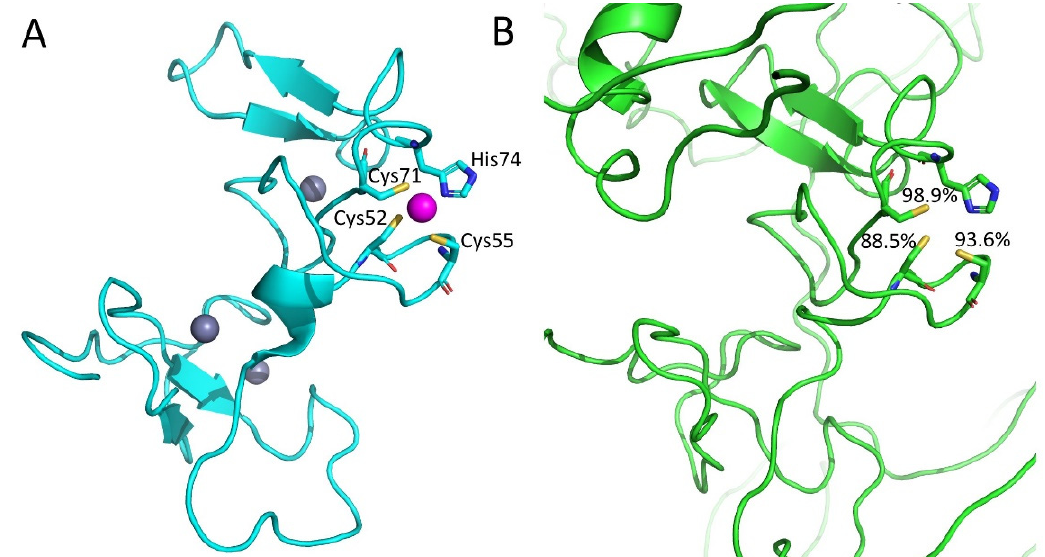
Figure 4. Comparison of a mouse zinc(II)-binding domain with the AlphaFold prediction of the whole structure and analysis of the site with DeepCys. ( A ) The first model of the NMR structure of the PHDVC5HCHNSD1 tandem domain of the Nsd1 protein from Mus musculus , with one of its four zinc(II) MBSs highlighted (the metal ion is in magenta) (PDB entry 2NAA [83]). ( B ) AlphaFold model of the entire human homolog of this protein (Uniprot entry Q96L73), with the corresponding site highlighted. The 2NAA structure was input to DeepCys to predict the likelihood that each of the three cysteines is metal-binding; this is mapped onto the model. Some parts of the model were omitted for clarity.